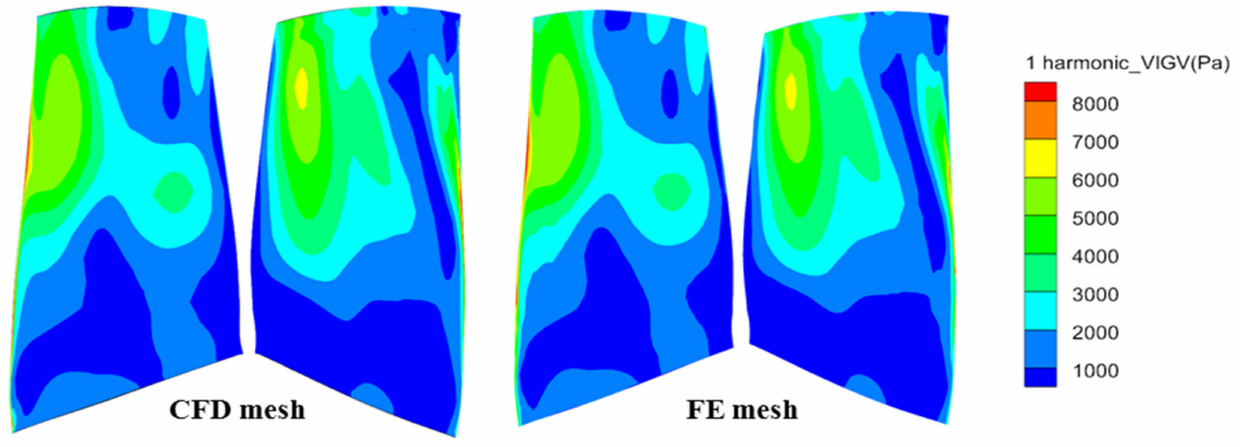
Figure 18. Comparison of the pressure